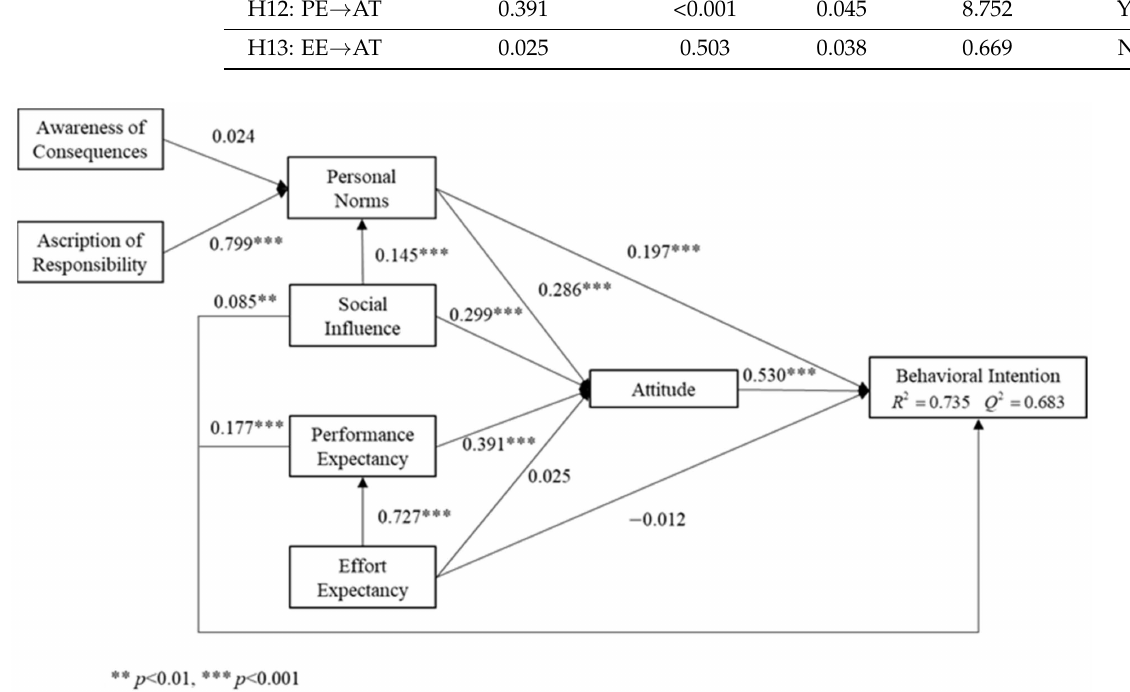
Figure 2. Model evaluation